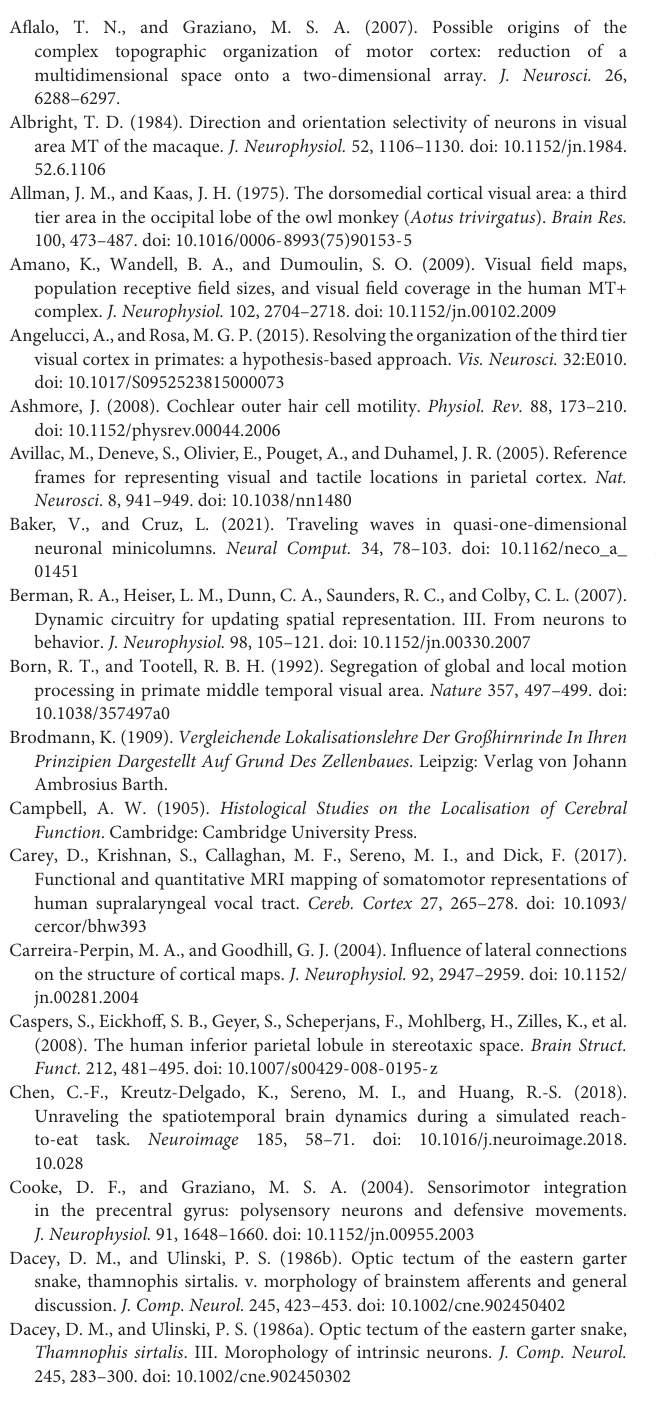
FreeSurfer average subject, fsaverage (surface: white). The first rotation around a vertical axis shows the parcellation, and the second rotation shows the topological map data. After each vertical-axis rotation, the brain is rotated around a horizontal axis to expose superior and then inferior areas. The color scale for the map data is the same as in Figure 6 and Supplementary Video 1 .